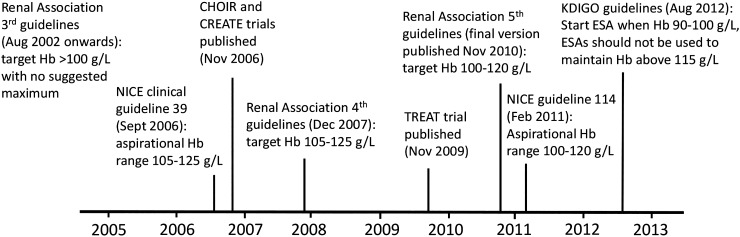
Timeline of events.